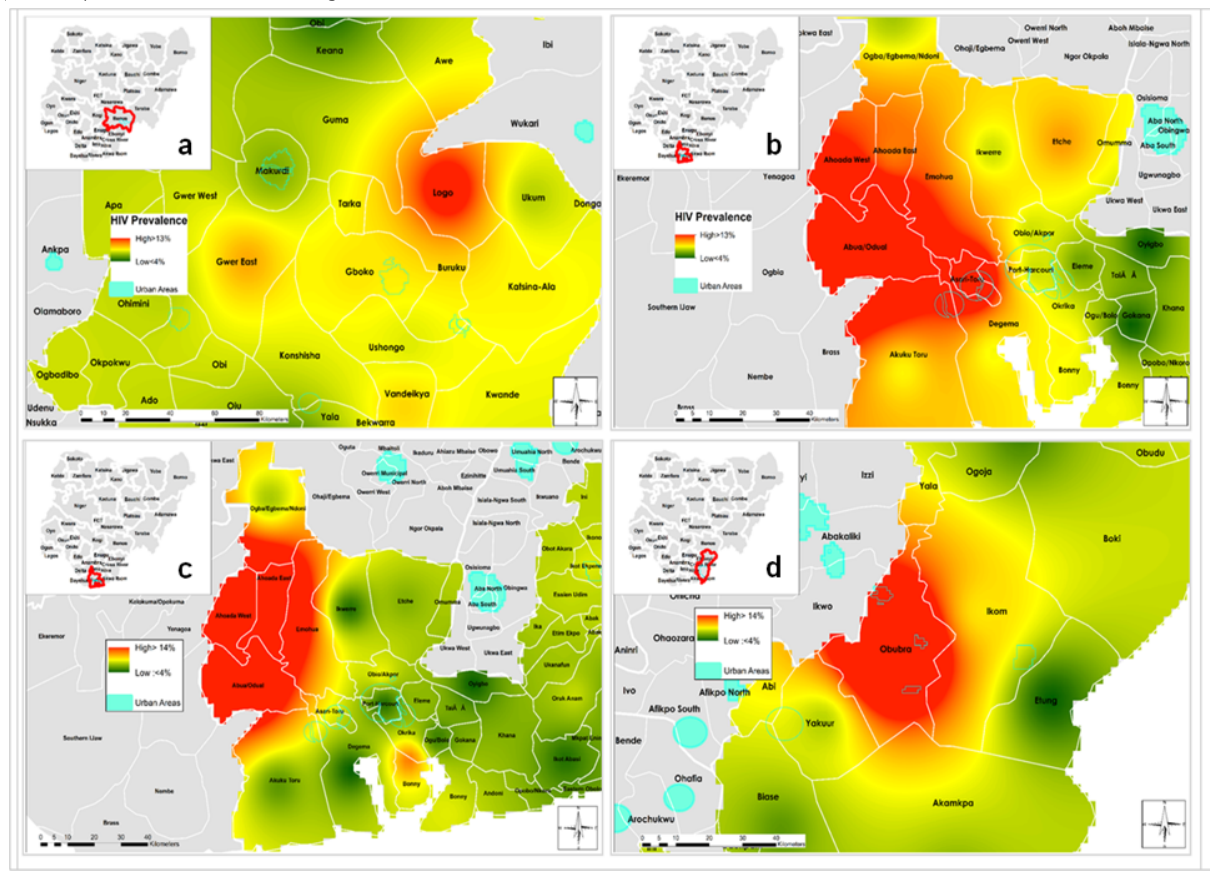
Figure 4. State level map of Nigeria showing urban locations and interpolated areas with high and low HIV seroprevalence by local government area among men who have sex with men (a: Benue; b: Rivers), and people who inject drugs (c: Rivers; d: Cross River). Seroprevalence >13% is shown in red, and seroprevalence <4% is shown in